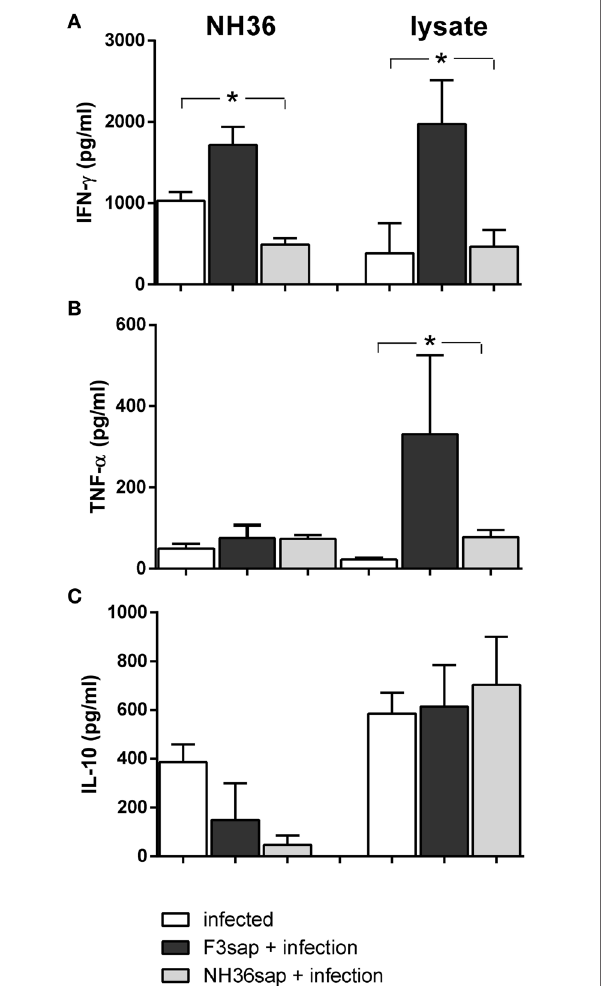
FigUre 8 | Cytokines secreted by dendritic cells (DCs) on day 28 after challenge. Secretion of IFN- γ (a) , TNF- α (B) , and IL-10 (c) were measured in supernatants of in vitro cultures of purified DCs obtained from infected, F3sap, and NH36sap vaccinated and infected in response to NH36 or Leishmania (L.) infantum chagasi lysate antigens, on day 28 after infection. Bars represent the mean + SE values of two-independent experiments ( n = 5 mice per treatment in each experiment). Asterisks and horizontal lines show significant differences between treatments as disclosed by Mann–Whitney non-parametrical test.